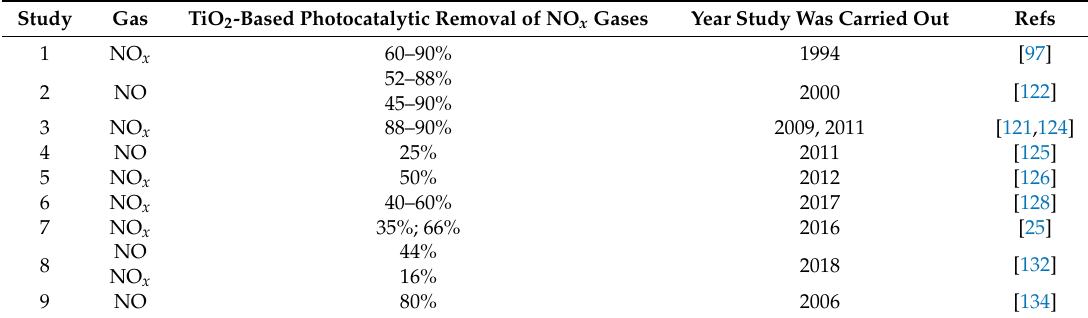
Table 7. Percent removal of NO x gases carried out with TiO 2 -based photocatalytic protocols in an indoor laboratory setting using small flow-through reactors under a variety of